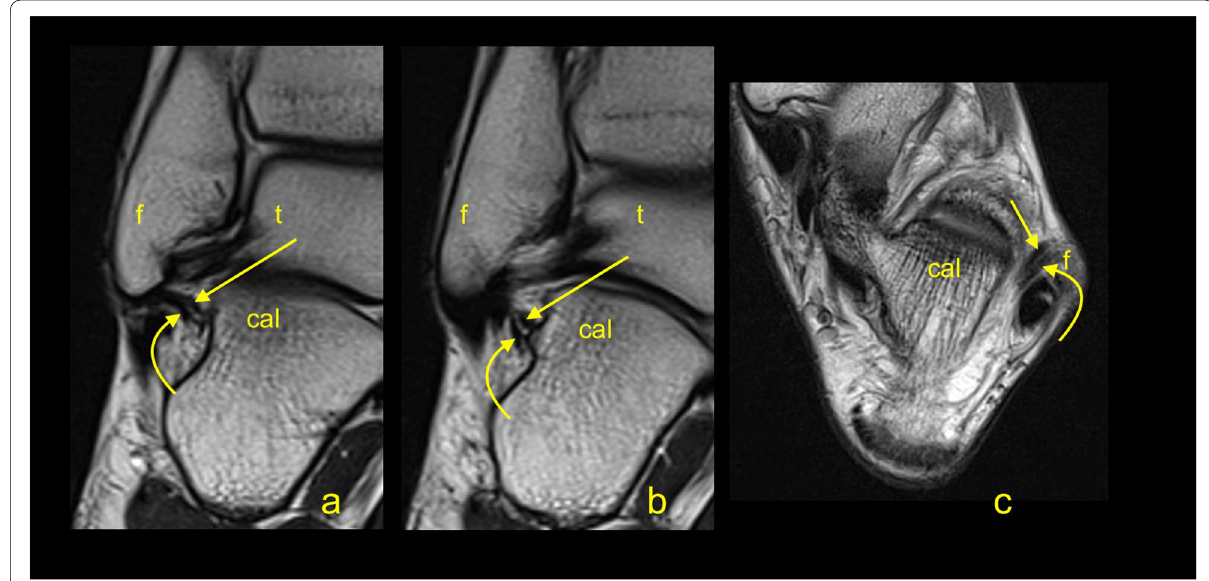
Fig. 7 The double fascicular calcaneofibular ligament. The medial (arrow) and lateral fascicle (curved arrow) are visible. A and b T2-weighted coronal section; c T2-weighted axial section. Cal, calcaneus; f, fibula; t, talus